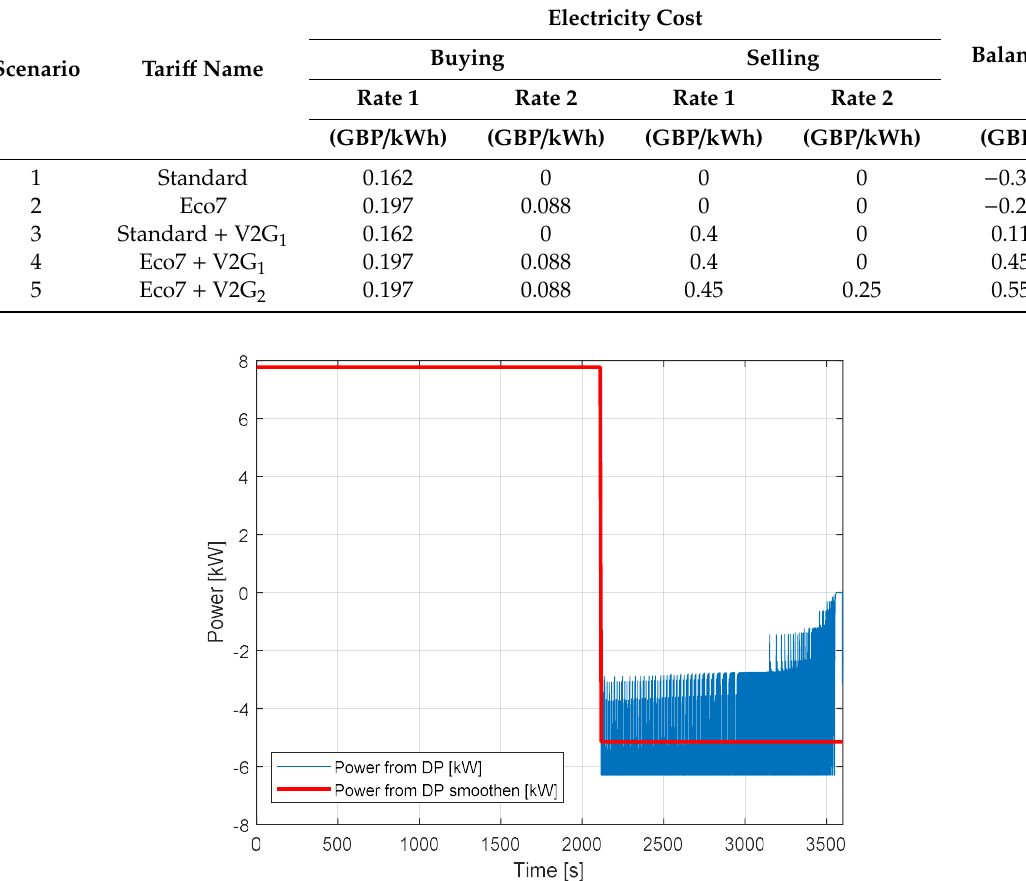
Figure 15. BEV owner’s dashboard.